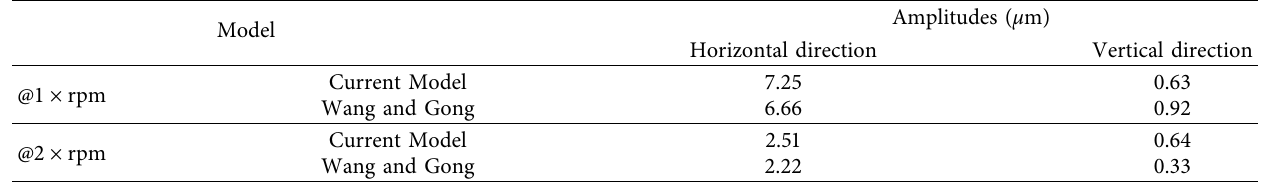
Figure 27: Response to the effects of imbalance and parallel misalignment based on Wang and Gong’s parameters. (a) Frequency response of x1. (b) Frequency response of x2. Table 11: Comparison of our model versus that of Wang and Gong